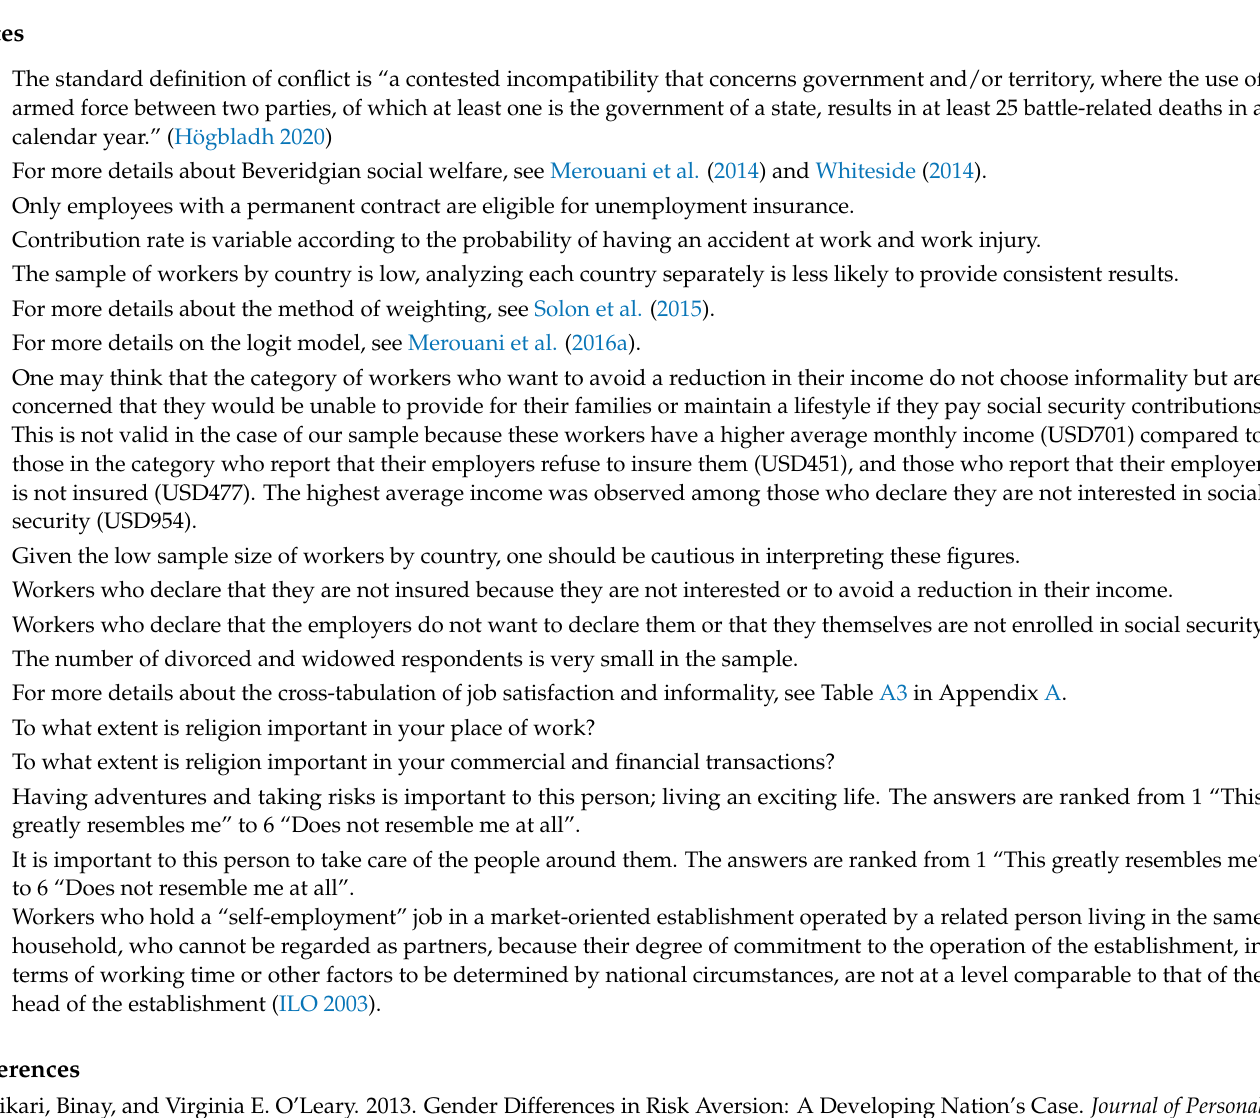
Figure A1. Densities of monthly log income. Source: Sahwa dataset using Stata.